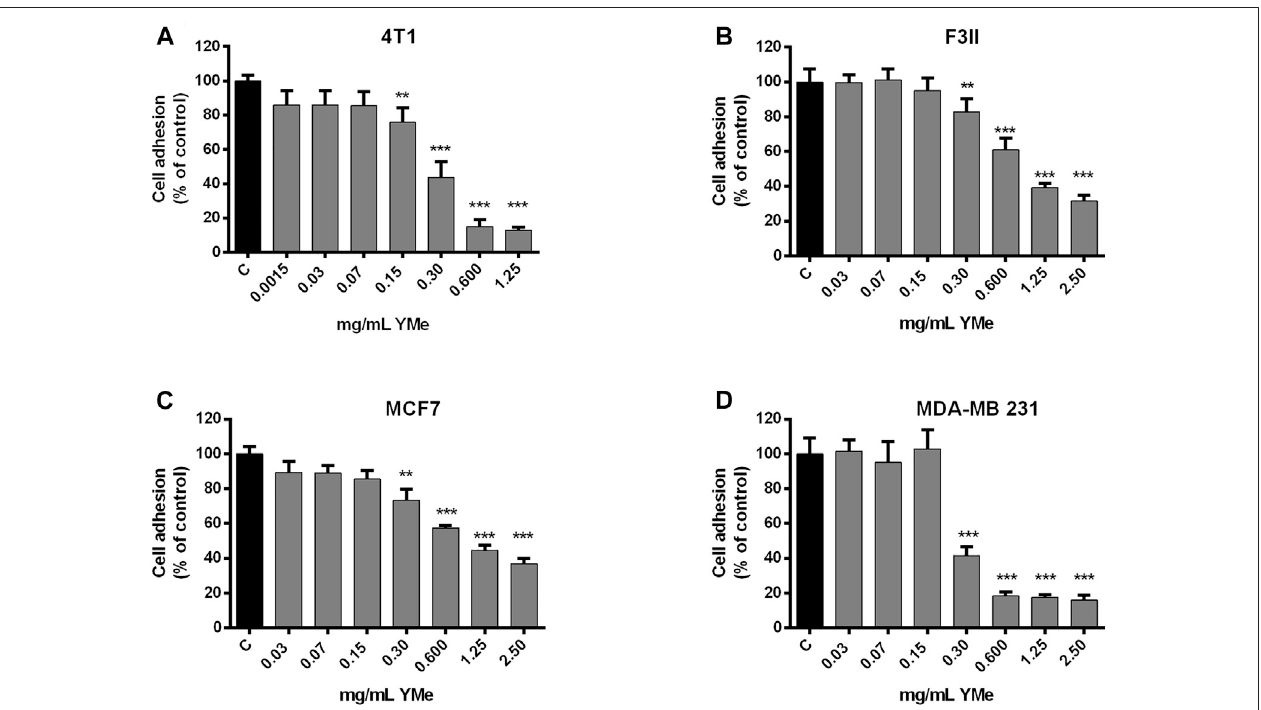
FIGURE 3 | Inhibitory effect of YMe on cell adhesion. 4T1, F3II, MCF-7 and MDA-MB 231 ( A,B,C,D respectively) BC cell lines were treated with increasing concentrations of YMe for 2 h. After washing, adherent cells were stained with crystal violet, solubilized in methanol-acetic solution (10%/5%, V/V) and the absorbance was measured at 595 nm. Data represent the means ± SD (n (cid:2) 6) and were expressed as percentage of adhesion respect to the control. Each point represents the average of six independent measurements, each done in triplicate with the standard deviation. Statistical analysis was done using ANOVA and Tukey post-test; ** p < 0.01, *** p < 0.001 vs.